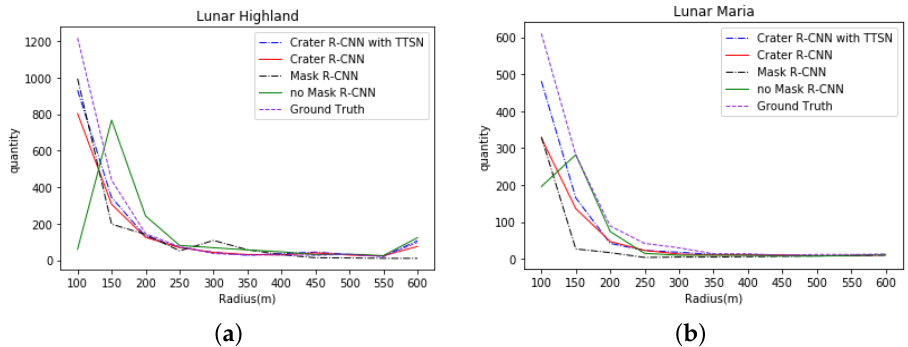
Figure 10. Distribution of the number of craters detected by Mask R-CNN, no-Mask R-CNN, Crater R-CNN, Crater R-CNN with TTSN, and manual labeling: ( a ) Highland; and ( b ) Maria.